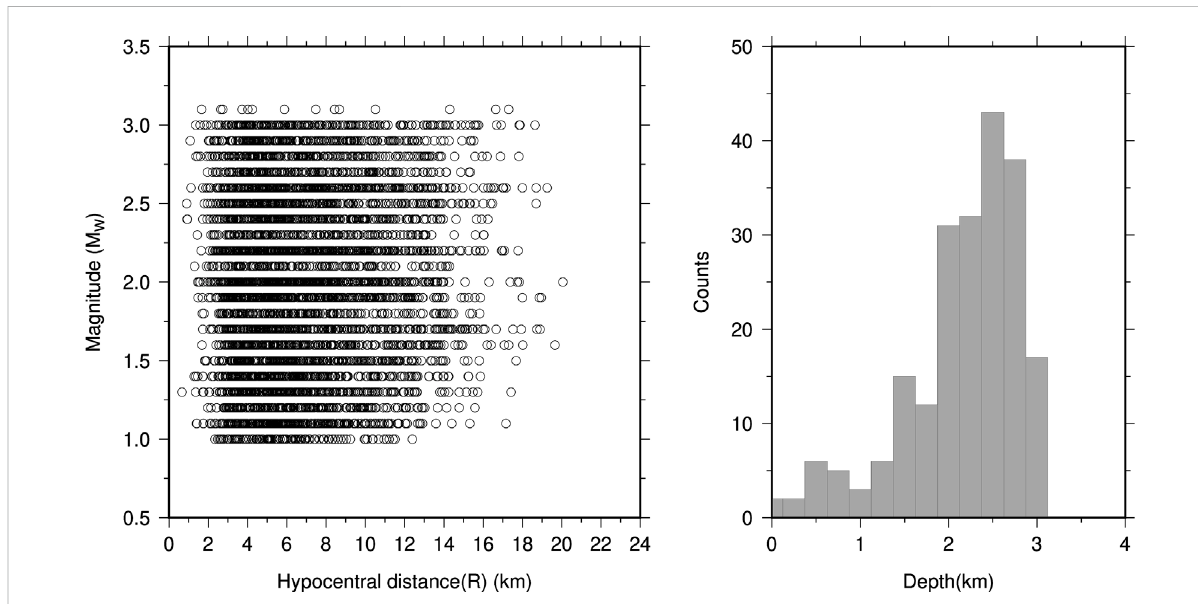
FIGURE 2 Scatter plot of the available strong-motion data in terms of Mw and R in the left-hand side plot and depth distribution of the analyzed earthquakes in the right-hand side